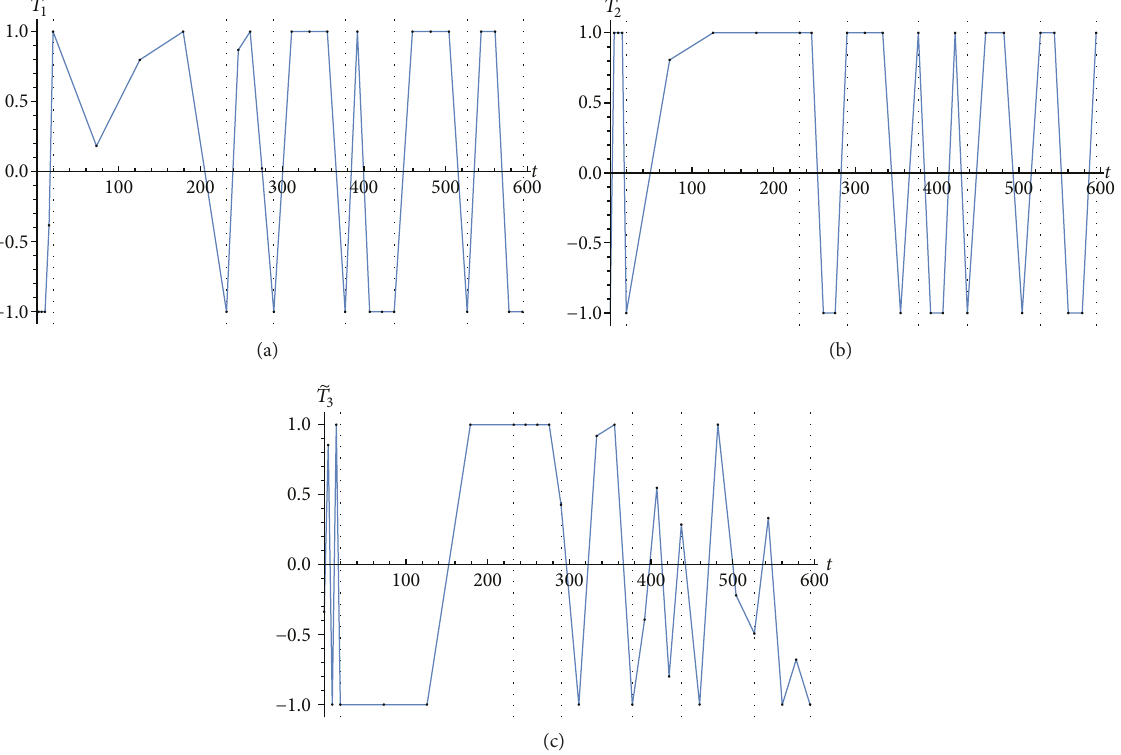
Figure 6: Control torques in experiment A with 6 target